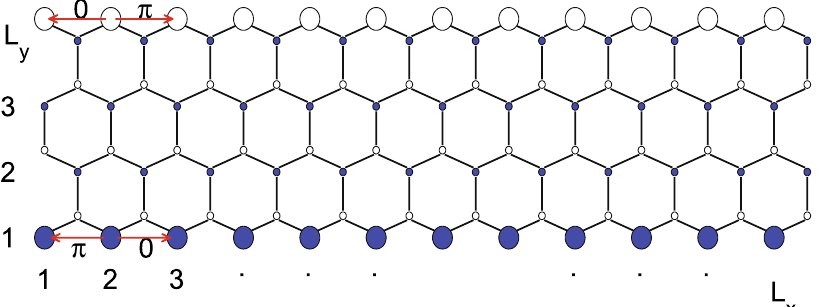
Figure 1. A piece of a honeycomb lattice displaying zigzag edges with L y = 4 which defines the width of the ribbon in the transverse direction and L x = 12, which defines the length in the longitudinal direction. The lattice sites at zigzag edge are much larger than the sites in the bulk, indicating that the charge carriers are moving along the edge.